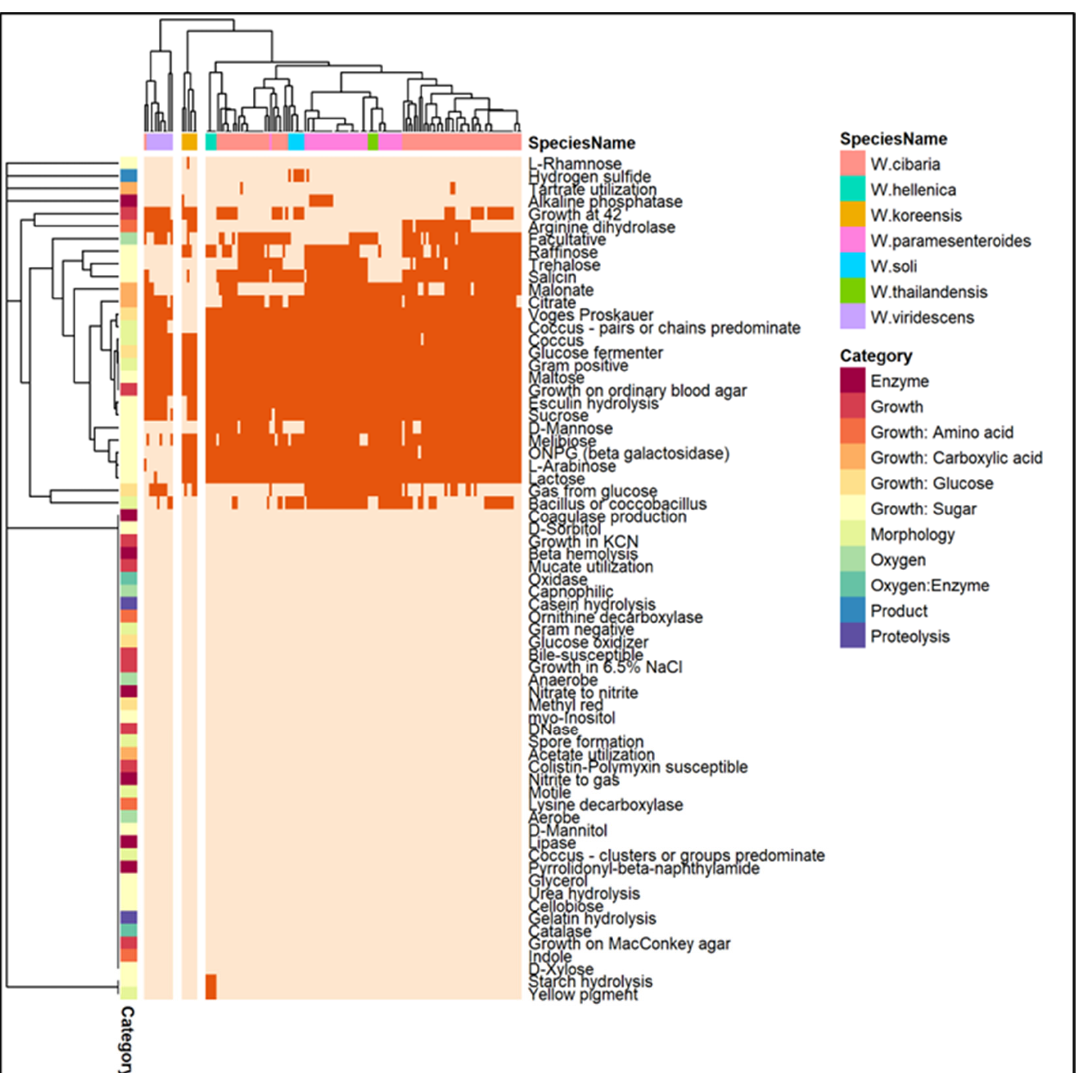
Figure 4. Predicted phenotypic characteristics of Weissella spp. with Traitar.